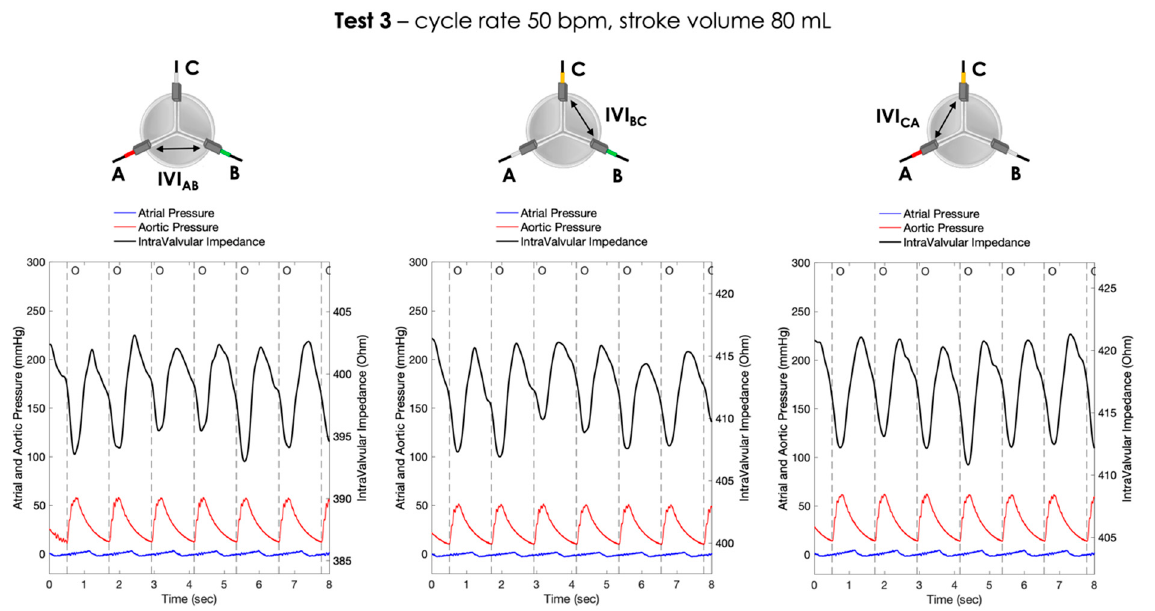
Figure 7. Atrial pressure, aortic pressure and IVI signal recorded inside the porcine heart in the three pairs of electrodes during Test 2 (cycle rate 50 bpm, stroke volume 70 mL): AB ( left ), BC ( center ) and CA ( right ). O = start of valve opening identified with the low peak of the aortic pressure.